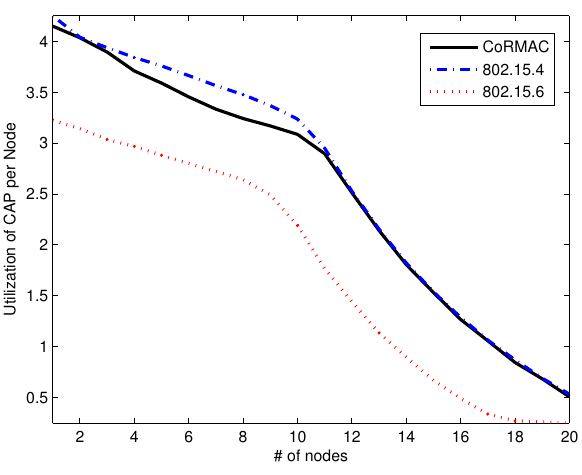
Figure 11. The utilization in CAP vs. the number of